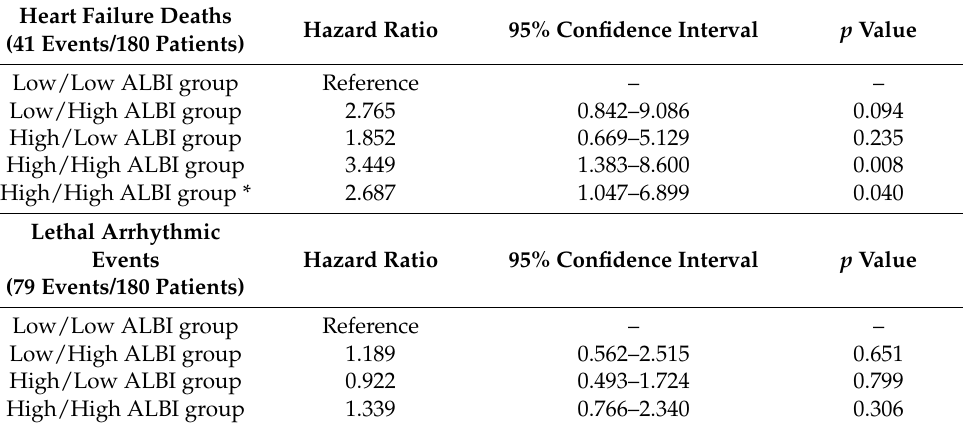
Figure 3. The incidence of adverse events (heart failure death or lethal arrhythmic event) among the four groups. ( A ) The cumulative incidence curve of heart failure death with a log rank test among the four groups. ( B ) The cumulative incidence curve of lethal arrhythmic events with a log rank test among the four groups. Table 3. Cox proportional hazard model of heart failure deaths and lethal arrhythmic events.